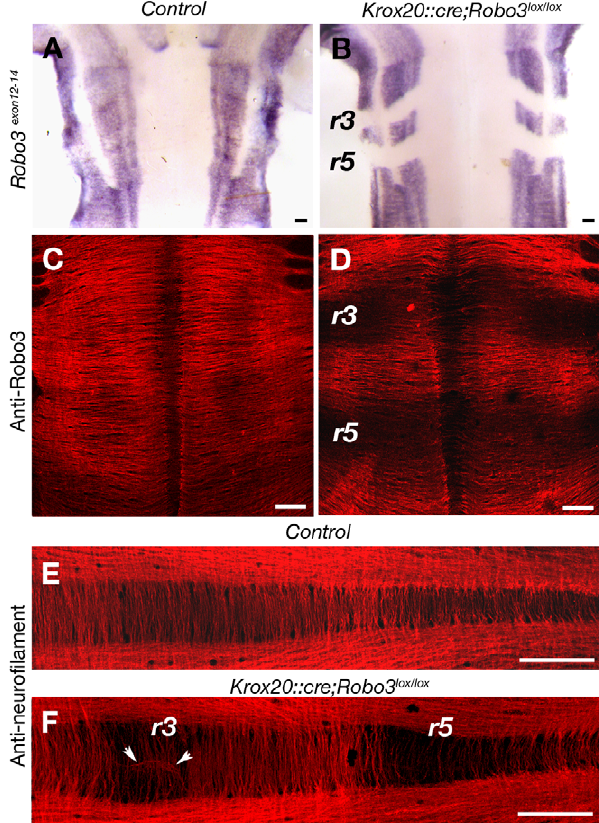
Figure 1. Rhombomere-specific deletion of Robo3. Whole-mount control (A, C, and E) or Krox20::cre;Robo3 lox/lox (B, D, and F) E12 embryos hybridized with a Robo3 riboprobe covering exons 12–14 (A and B) or immunostained with anti-Robo3 (C and D) or anti-neurofilament (E and F) antibodies. (B) In Krox20::cre;Robo3 lox/lox embryos, Robo3 exon12-14 transcripts are not expressed in rhombomeres 3 (r3) and 5 (r5). (C and D) Likewise, there is a severe reduction of Robo3 immunoreactive commissural axons in r3 and r5. (E and F) Anti-neurofilament immunostaining confirms the strong reduction of commissures in r3 and r5. The arrowheads in (F) indicate axons that abnormally follow the midline. Scale bars represent 100 m m.